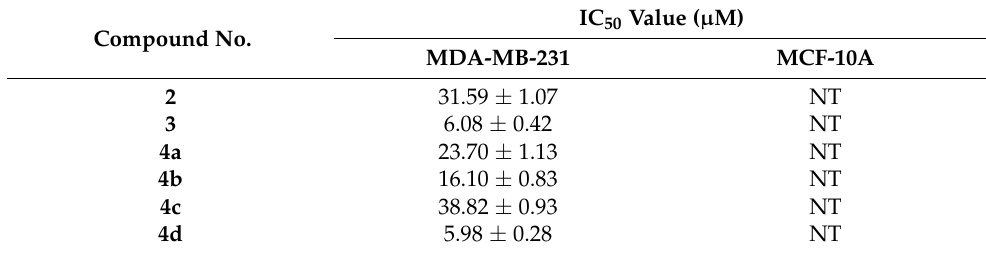
Table 1. Cytotoxic screening of the tested Schiff bases 2 – 5g . Values are the mean of three independent replicates ±